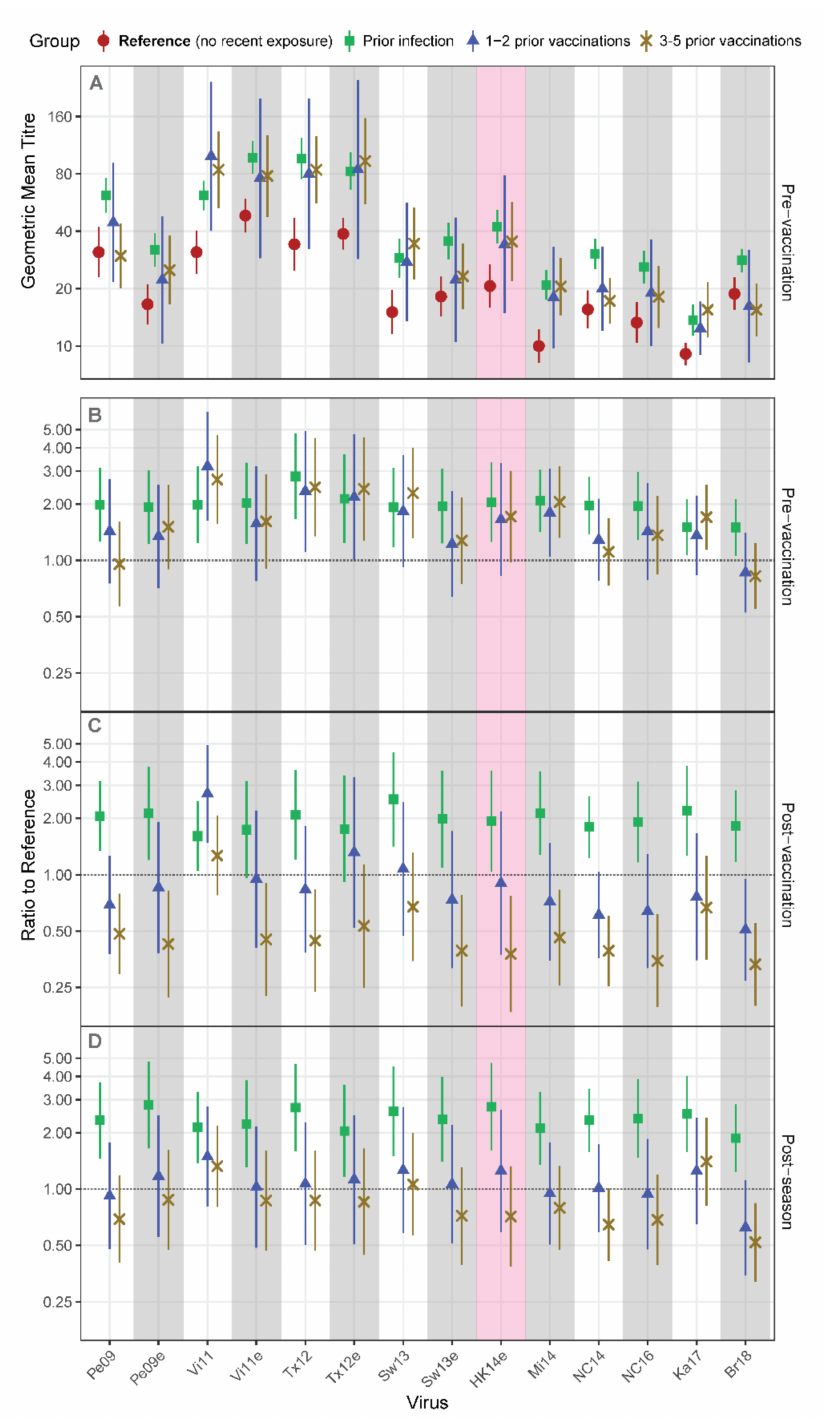
Figure 3. Recent strain antibody titers of groups with documented prior exposure to A(H3N2) compared to a reference group with no recent exposure. Ha Nam Cohort participants who lacked recent A(H3N2) exposure were assigned as the reference group. Pre-vaccination titers against A(H3N2) viruses are shown for each prior exposure group in ( A) , and are presented as ratios compared to the reference group in ( B ). Post vaccination and Post season ratios to reference group are presented in ( C ) and ( D ). Numbers per group are given in Table 3. Results are presented as geometric mean titers ( A ) or as estimated mean ratios to reference ( B – D ) with 95% confidence intervals. The red shaded panel indicates the current vaccine